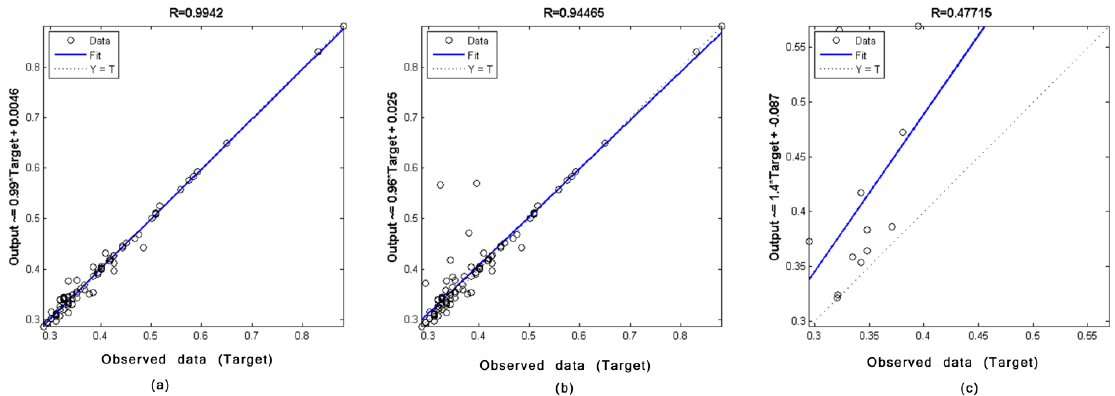
Figure 5. Goodness of fit between the output of the BP ‐ ANN model and the target using ( a ) trained data from 2003 to 2010; ( b ) all the data from 2003 to 2011; and ( c ) tested data of the year 2011.